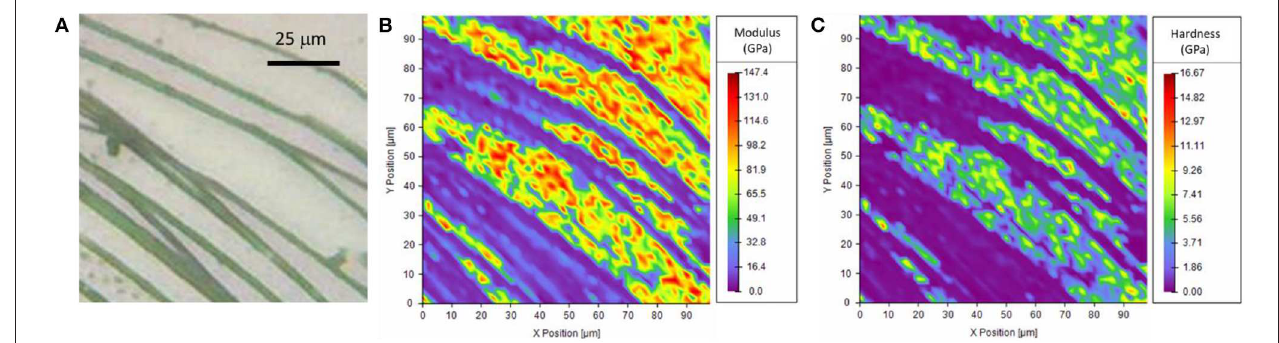
FIGURE 4 | (A) Optical microscopy image of the sample, (B,C) Nanoindentation mapping of the mechanical properties of the piriform silk on the border of the attachment disc. Note that high values result from measurements of the quartz substrate exposed between the (softer) silk fibrils.